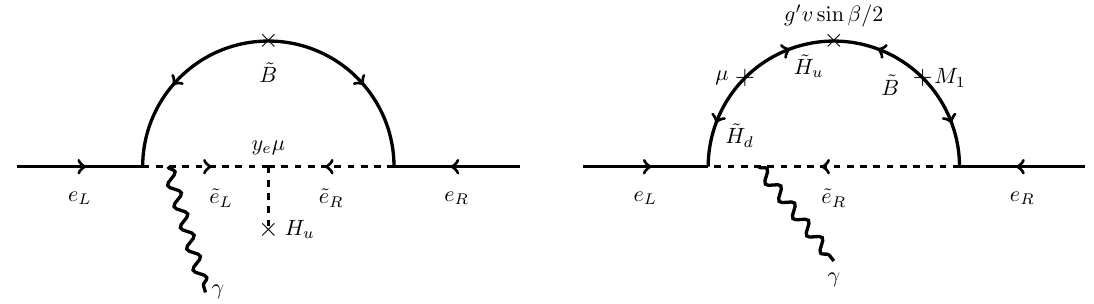
Figure 7. One-loop diagrams contributing to the electron EDM involving higgsinos or right- handed selectrons, but without flavor violation. Both diagrams may be sensitive to a subleading, CP-violating phase arg( µM 1 ) arising from gravity-mediated contributions. At left: a diagram that is sensitive to µ through the mixing of ˜ e L and ˜ e R . At right: a diagram involving only ˜ e R together with bino-higgsino